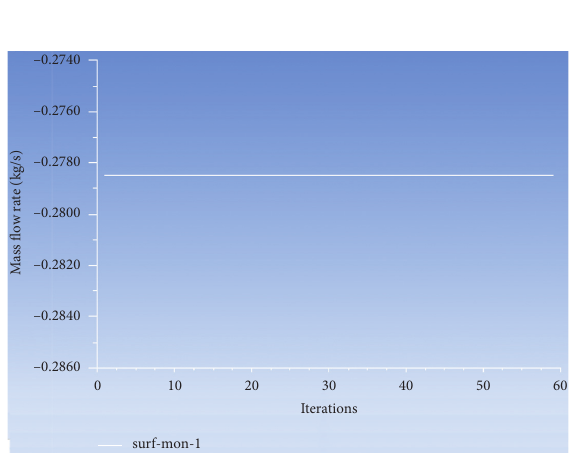
Figure 7: Flow of fluid at the exit of the mesh file.